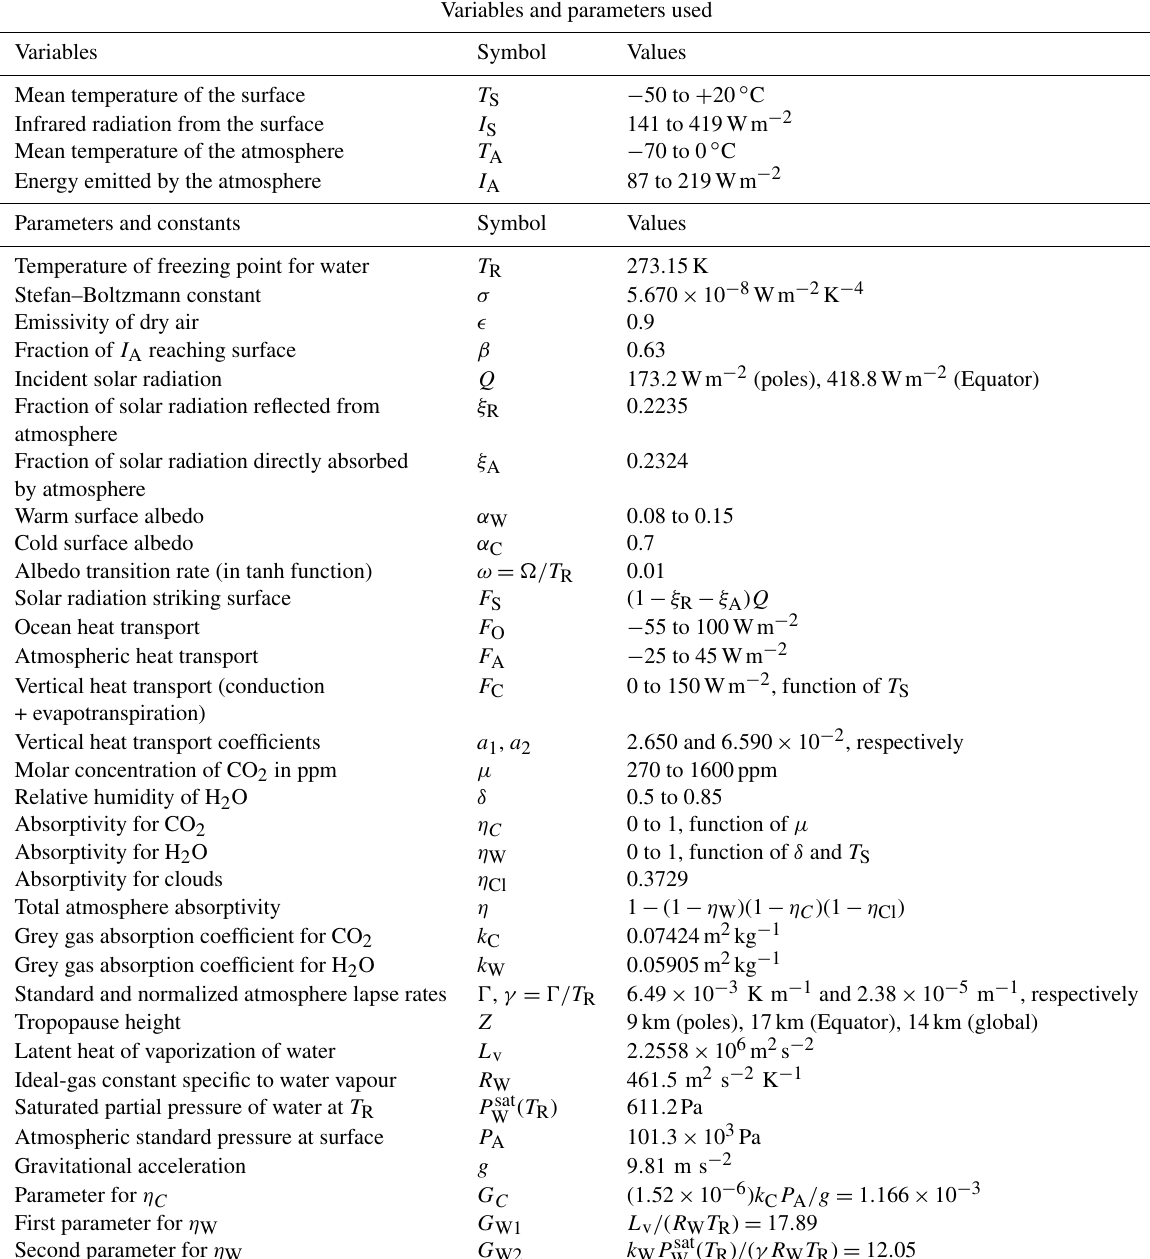
Table 1. Summary of variables and parameters used in the model. Many of these parameters have standard textbook values (e.g. T R ,σ,L v ,R W ). The standard lapse rate (cid:48) is from ICAO (1993). Other parameters such as k C and k W are derived in Appendix